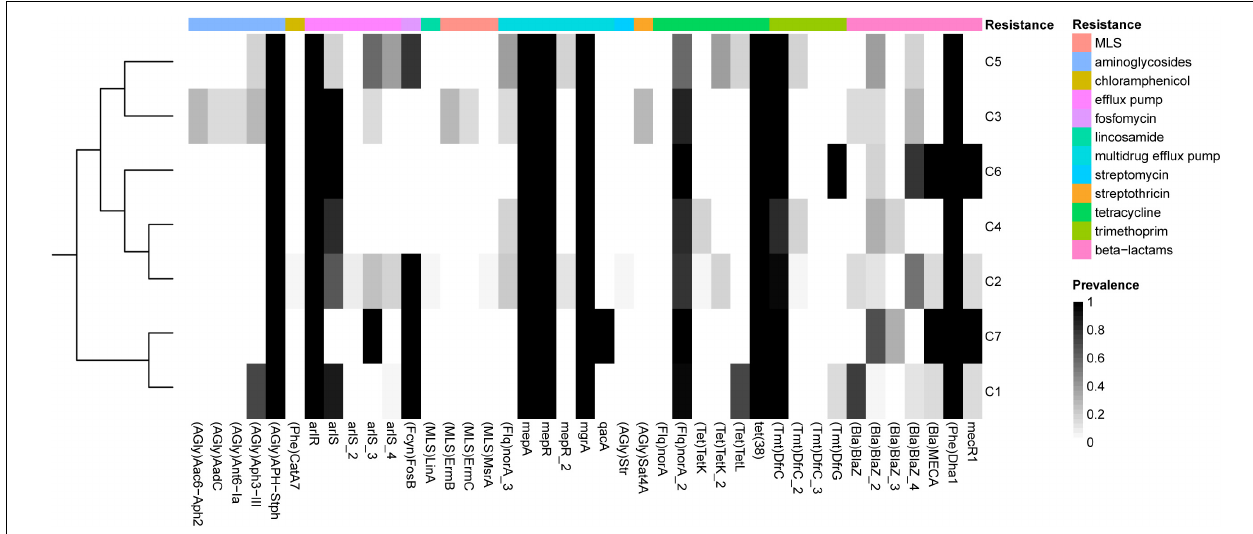
FIGURE 4 | Prevalence of antibiotic resistance-related genes in each of the S . argenteus clusters. The genes conferring different types of resistance are indicated by bars of different colors.